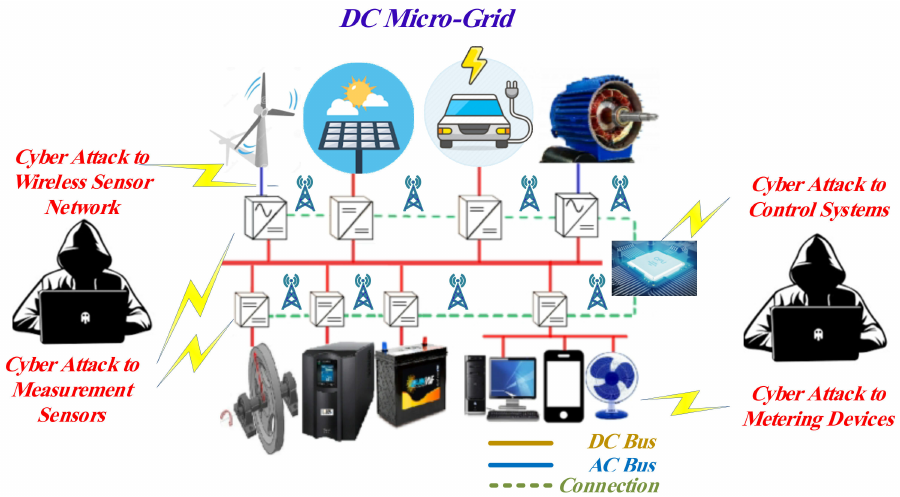
Figure 3. The framework of MG as a CPS